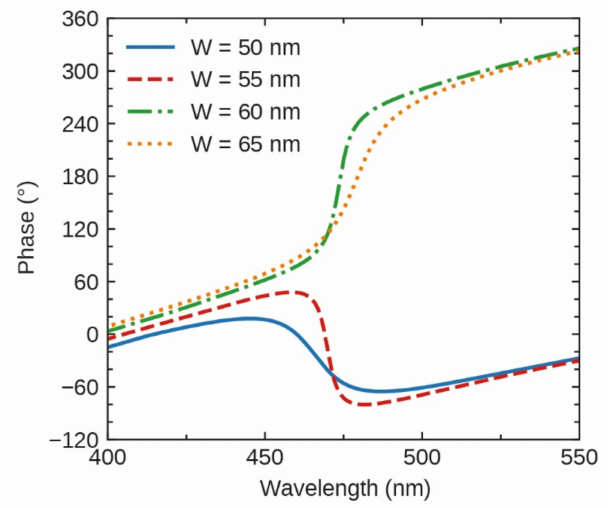
Figure A5. Phase behavior of the nanobricks with a 30 nm spacer layer, 30 nm brick height, 160 nm pitch, 80 nm length, and widths of 50, 55, 60, and 65 nm. A transition from an overdamped to an underdamped system is indicated by the fast nearly 2 π phase jump between a width of 55 and 60